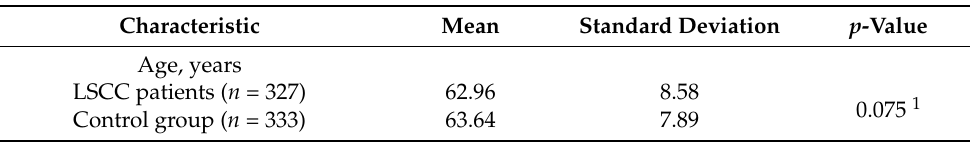
Table 2. Characteristics of study